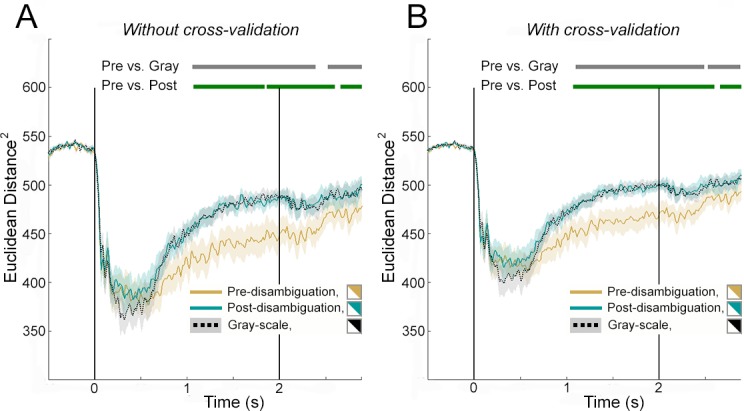
Mean across-image representational dissimilarity in each perceptual condition for real image sets, calculated using Euclidean distance.Similar to Figure 4D, except that representational dissimilarity was computed as squared Euclidean distance. Horizontal bars denote significant differences between conditions (p<0.05, cluster-based permutation tests). Non-cross-validated (A) and cross-validated (B) results yield similar time courses differing slightly in overall amplitude. Significant differences between Pre and Post conditions begin at 1070 ms for both methods. Significant differences between Pre and Gray conditions for non-cross-validated and cross-validated results begin at 1060 ms and 1100 ms, respectively. Cross-validation was carried out using a three-fold scheme. Note that due to the preprocessing step of normalizing MEG data across sensors at each time step (see Materials and methods, RSA), both Euclidean distance and the original 1 – r measure capture the angle between two population activity vectors (for discussions on the angle measure, see Baria et al., 2017). In addition, baseline correction (see Materials and methods, MEG data preprocessing) necessitated that angle difference in the pre-stimulus period is largest.